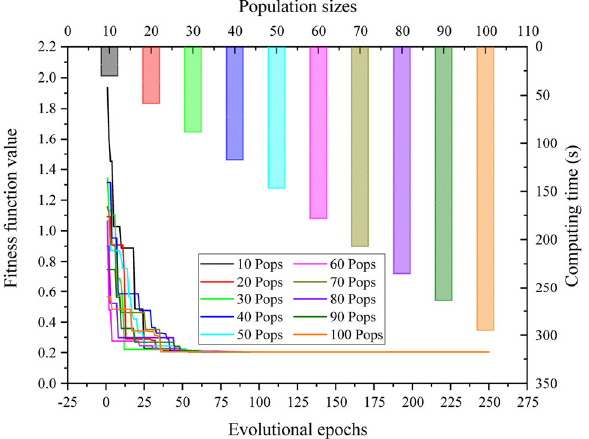
Fig. 16 Effect of different population sizes on the convergence of the fitness function.